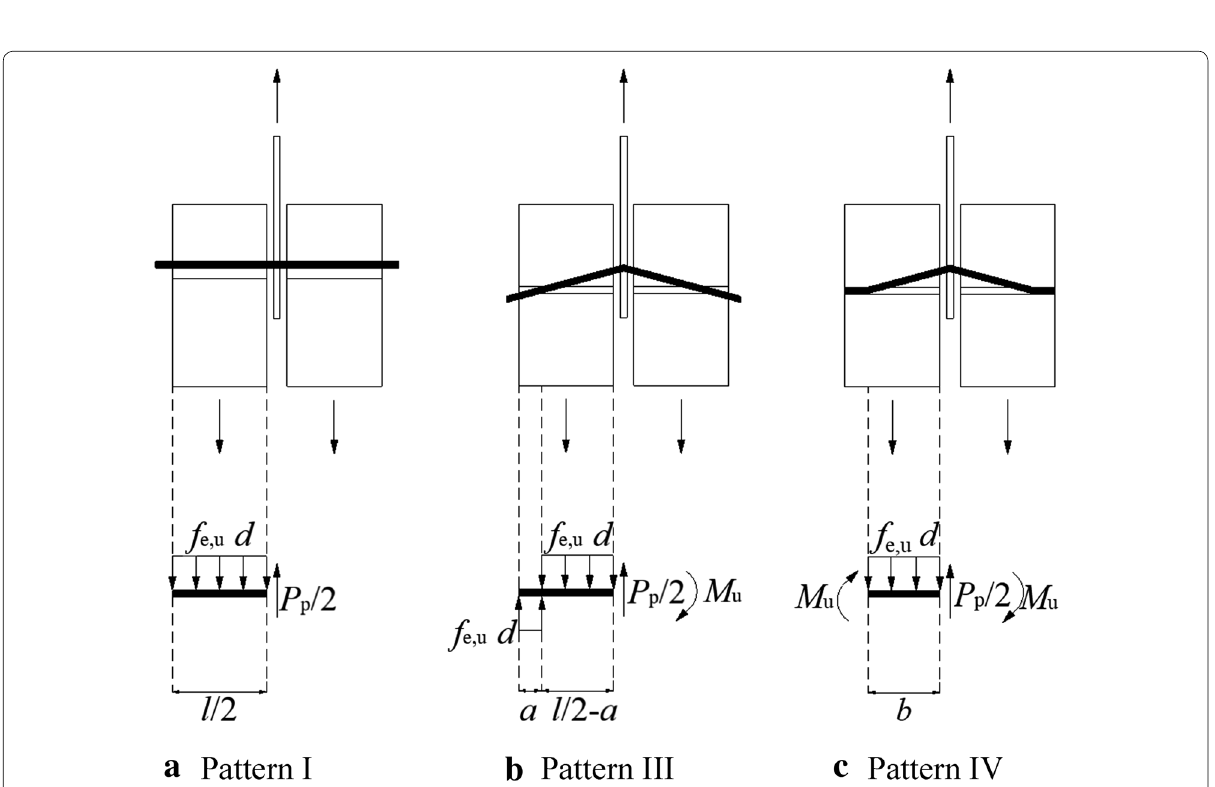
Fig. 10 Free body diagrams of the joint in the limit